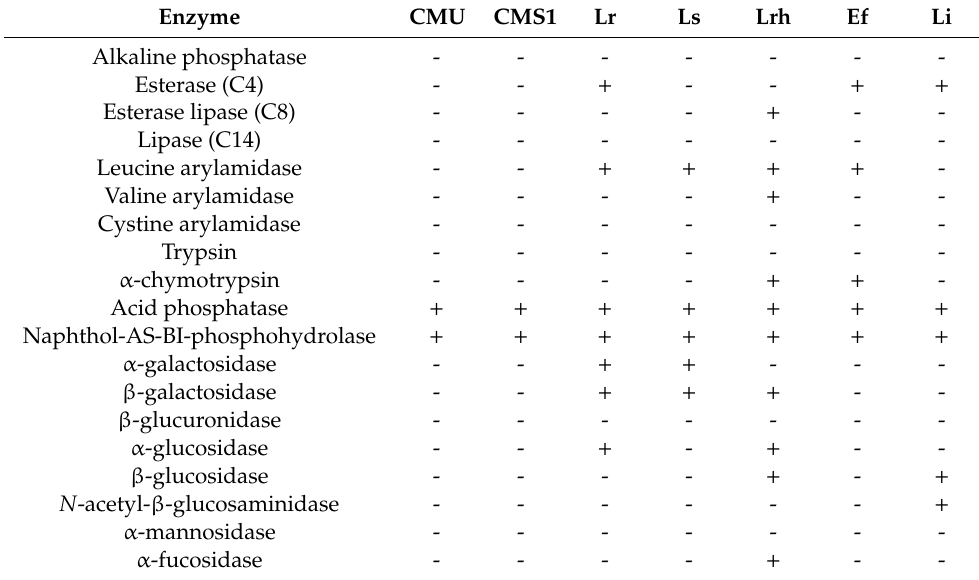
Figure 6. The β -glucuronidase activity ( A ), indole production ( B ), nitroreductase activity ( C ), gelatin liquefaction ( D ), and phenylalanine degradation ( E ) by W. cibaria strains. 1, W. cibaria CMU; 2, W. cibaria CMS1; 3, W. cibaria KCTC 3807; and 4, positive control (from A to C , E. coli O157:H7; D , P. aeruginosa KCCM 11328; and E , P. vulgaris KCTC 2512). Table 6. Enzymatic profiles of the studied bacterial strains determined by API ZYM test which detects the activity of enzymes on 19 substrates.